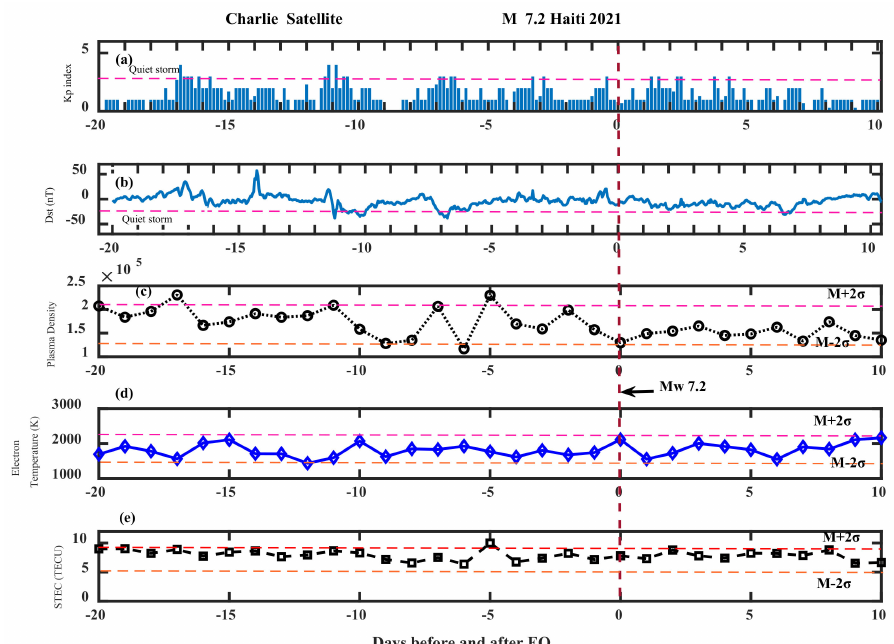
Figure 10. ( a ) and ( b ) The storm display of Dst and Kp for M w 7.2 (Haiti). ( c ) Plasma density ( d ) Electron Temperature (ET) ( e ) STEC of Swarm-C satellite for M w 7.2 (Haiti). The red dashed line represents the EQ day.